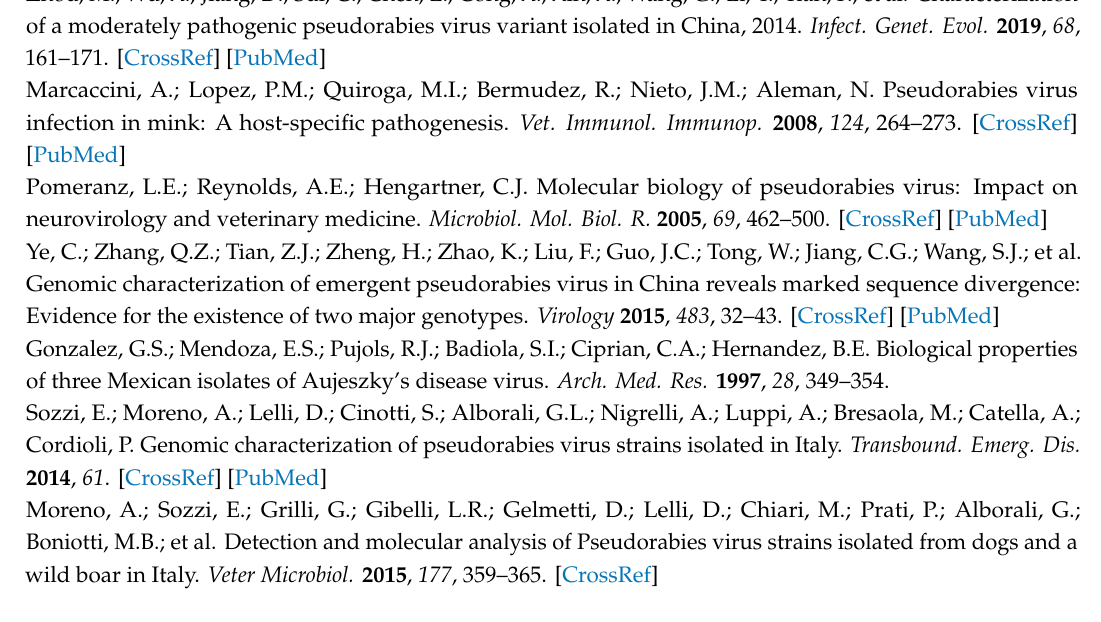
Figure S1: Identification of the cell